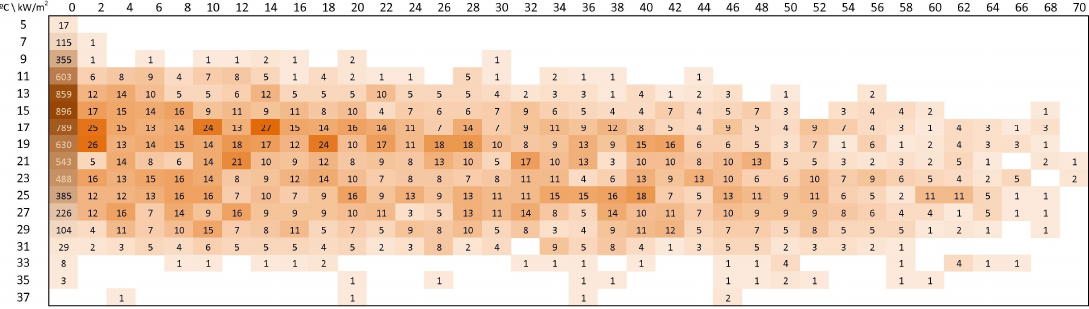
Figure 7. Frequency matrix for LFR in Almeria: modified DNI·CF-temperature.